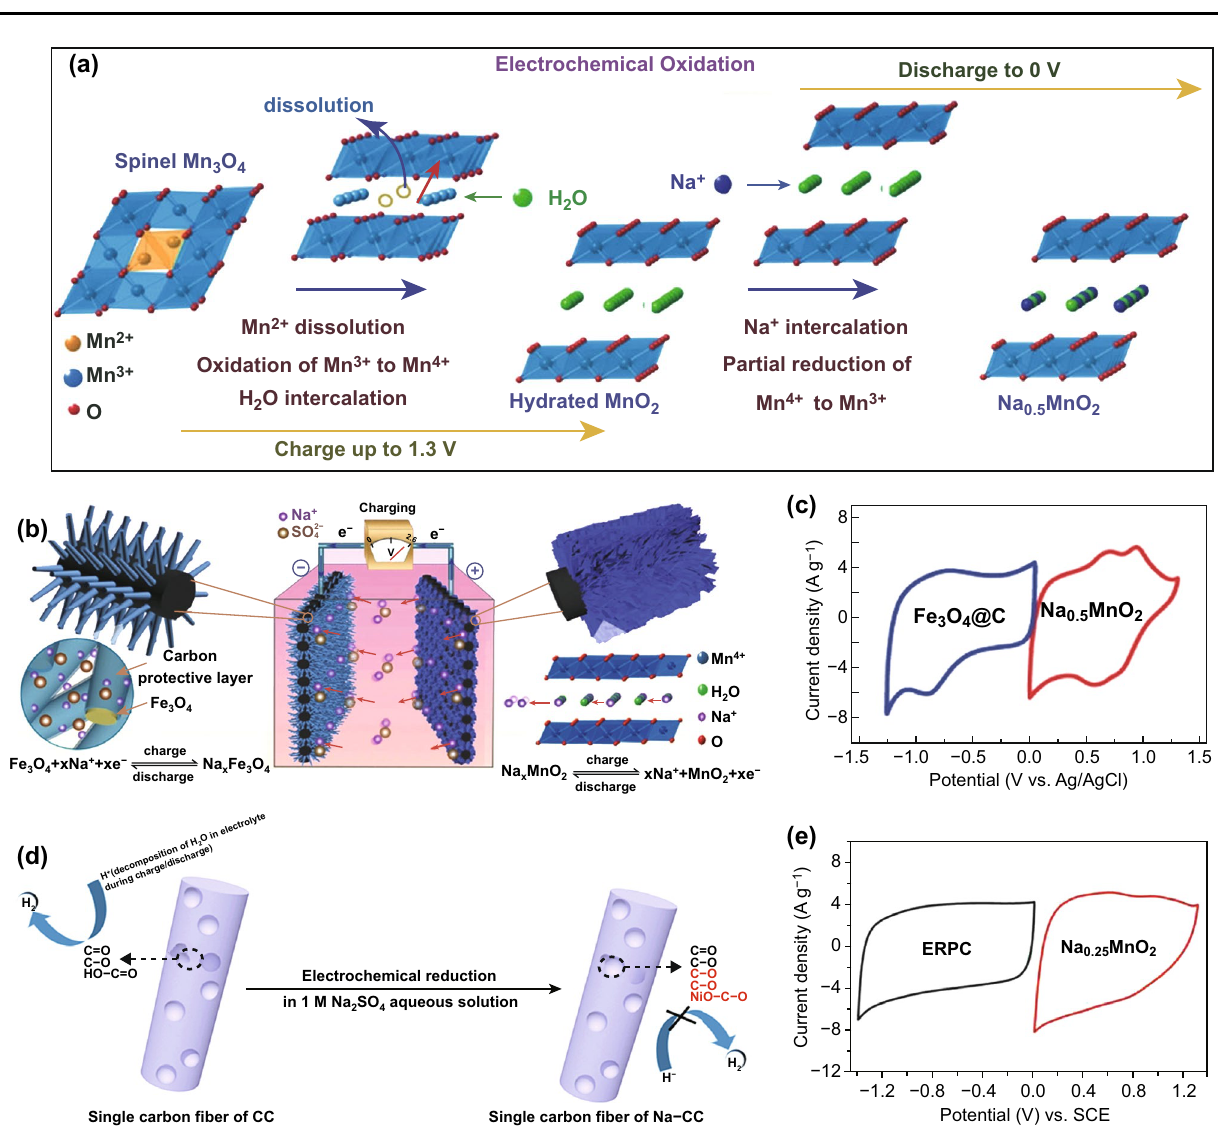
Fig. 2 a Structural evolution process of Na 0.5 MnO 2 during the electrochemical oxidation. b Electrode designs and charge‑storage mechanism of the Fe 3 O 4 @C anode and the Na 0.5 MnO 2 NWAs cathode in the aqueous ASC system. c CV curves of the Na 0.5 MnO 2 NWAs and Fe 3 O 4 @C elec‑ trodes in separate potential ranges at a scan rate of 10 mV s −1 . Adapted with permission from Ref. [31]. d Reaction schematic of alkali cations (Na + ) on carbon‑based electrodes. Adapted with permission from Ref. [28]. e CV curves of the Na 0.25 MnO 2 and the ERPC electrodes in separate potential ranges at a scan rate of 25 mV s −1 . Adapted with permission from Ref.